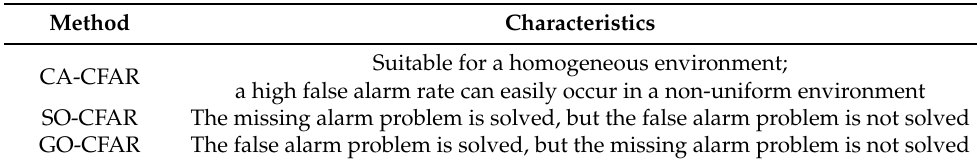
Table 1. The characteristics of traditional